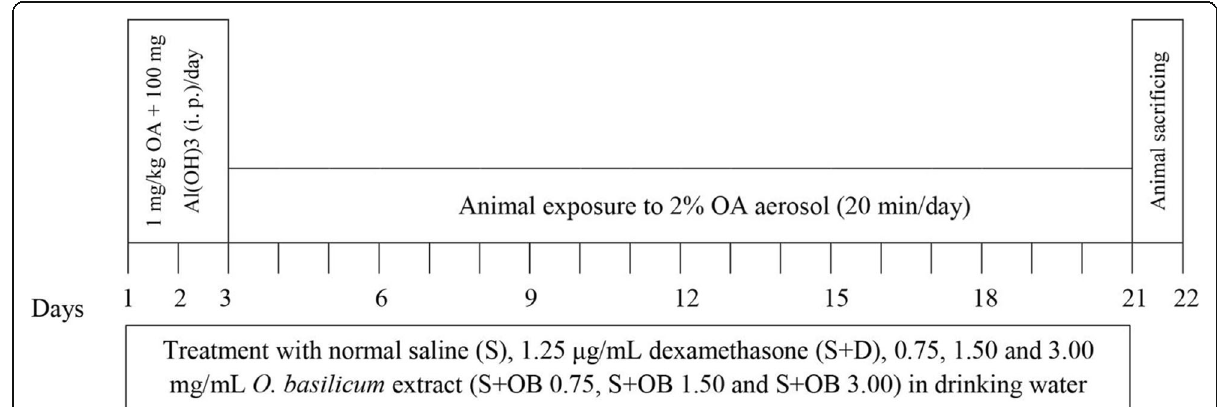
Fig. 1 Sensitization method of rats by ovalbumin (OA), 1 mg/kg + 100 mg Al(OH)3 as adjuvant and treatment of